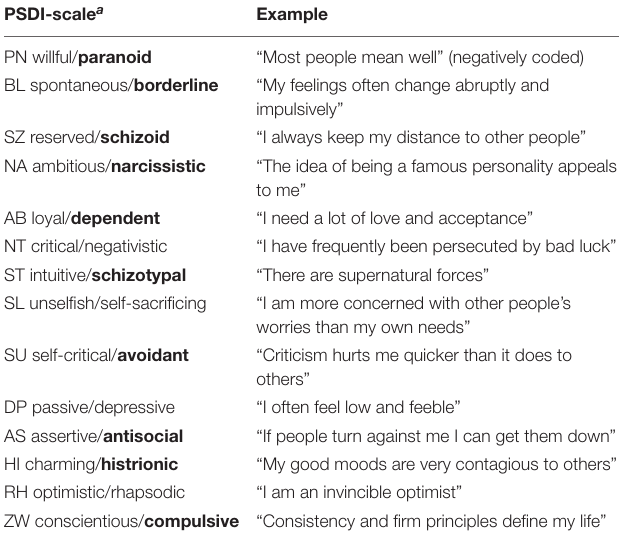
TABLE 1 | The 14 scales of the Personality Styles and Disorder Inventory (PSDI; Kuhl and Kazén, 2009). PSDI-scale